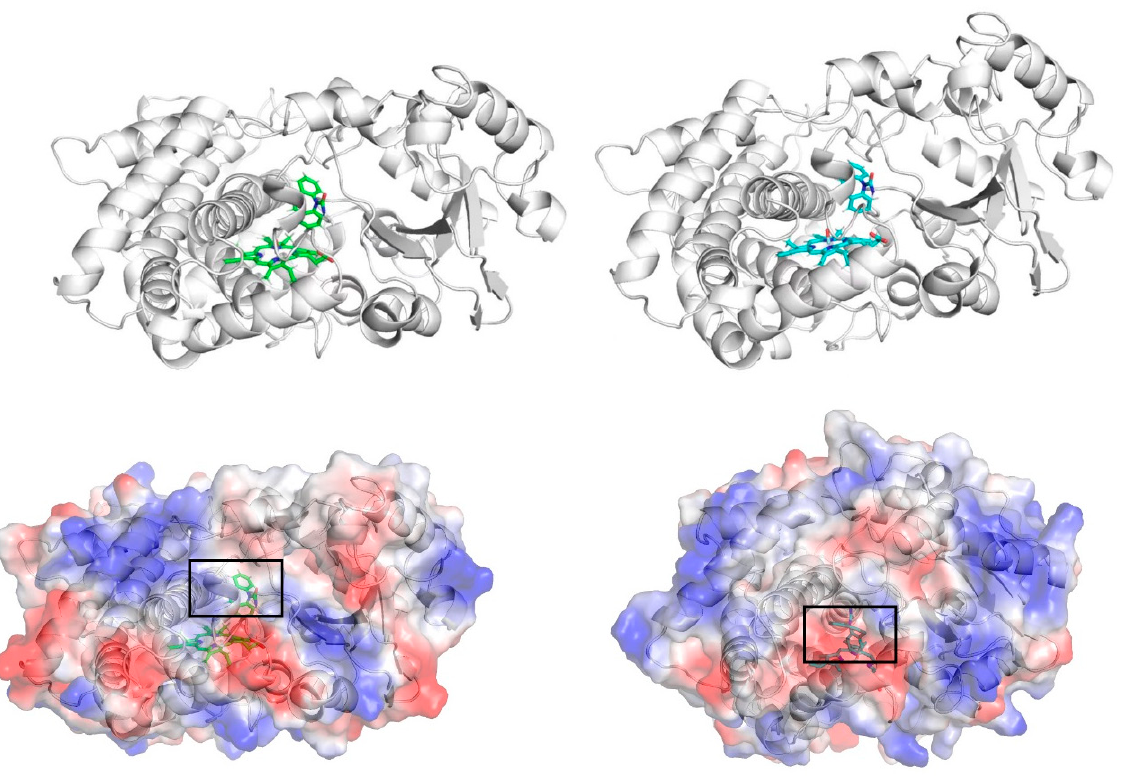
Figure 6. The electrostatic surface potential maps of the CYP proteins in two complex systems, CYP3A4-CBZ ( left ) and CYP3A5-CBZ ( right ).The ligand CBZ in each isoform is marked with a black square box.